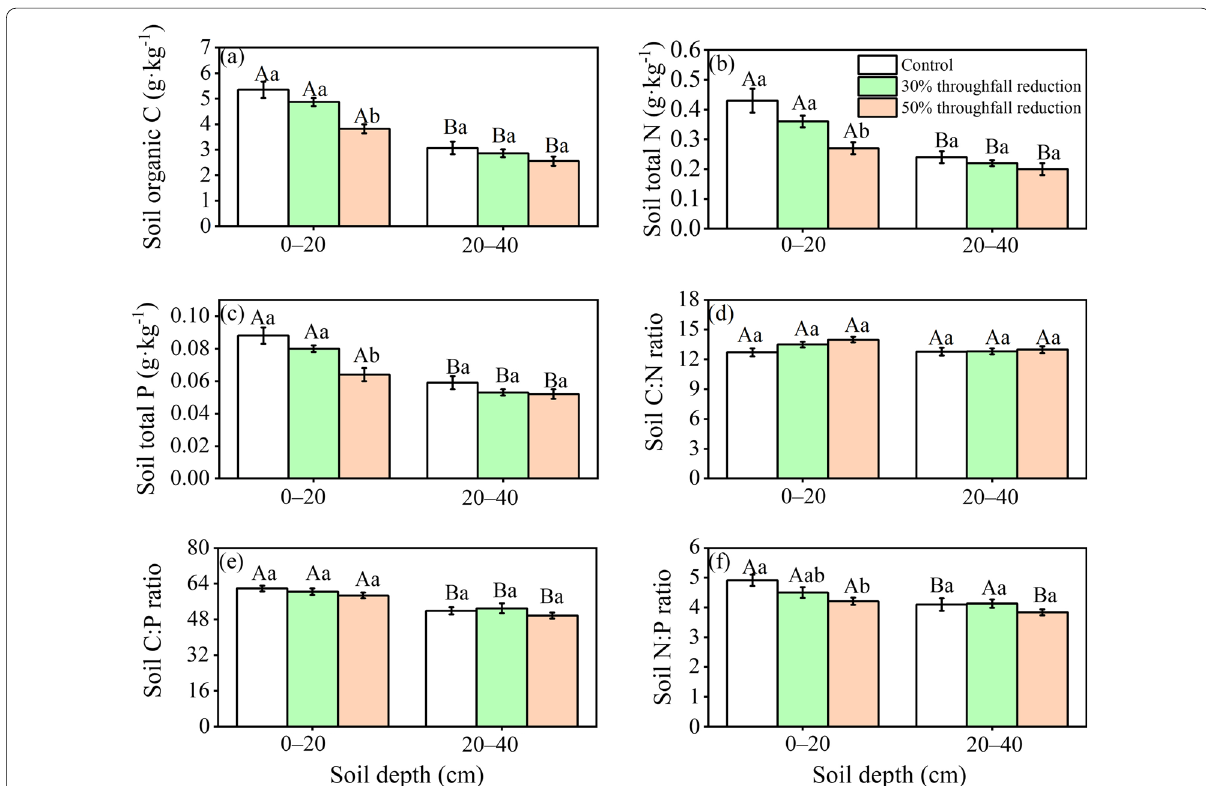
Fig. 4 Effect of drought on soil organic C, total N, total P concentrations, C:N ratio, C:P ratio and N:P ratio (Mean Different uppercase letters above the bars indicate significant differences between soil layers at each drought treatment, and different lowercase letters above the bars indicate significant differences among three drought treatments at each soil